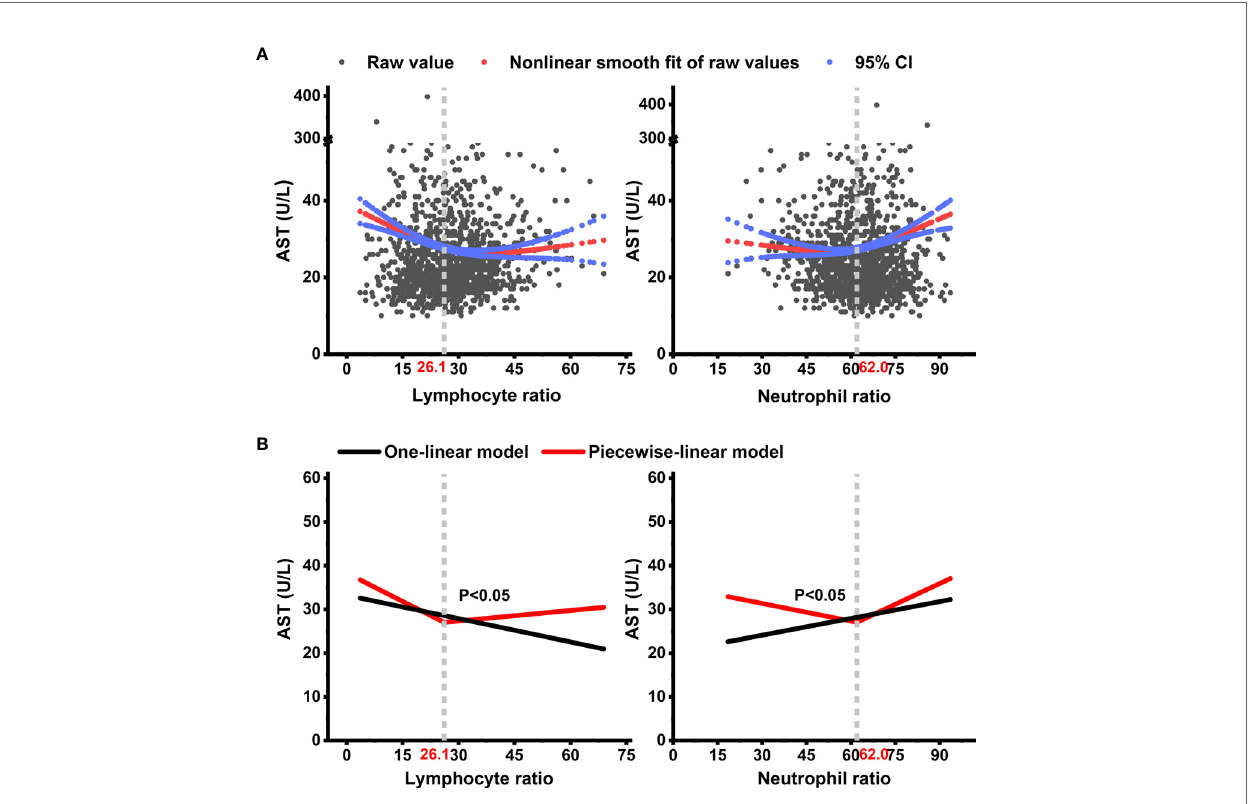
FIGURE 2 | Non-linear trajectories of AST with the changes of lymphocyte ratio and neutrophil ratio during the lateral observation period among COVID-19 patients. Non-linear trajectories of AST with the changes of lymphocyte ratio and neutrophil ratio can be approximated with a piecewise-linear mixed effect model. (A) shows the adjusted smooth fi t of AST data. (B) shows the fi t from the adjusted one-linear and adjusted piecewise-linear mixed-effect models. Models adjusted for fi xed covariates including age, sex, body mass index (BMI), SBP, smoking, alcohol, highest temperature, chest congestion, liver cirrhosis, HBV, and clinical classi fi cation on admission, and time-varied covariates including white blood cell count (WBC), rapid C-reactive protein (RCP), serum amyloid A protein (SAA), alkaline phosphatase (ALP), activated partial thromboplastin time (APTT), glomerular fi ltration rate (GFR), lipoprotein A (LppA), hemoglobin (Hb), sodium concentration, actual base excess (ABE), and anion gap (AG) during the lateral observation period. AST, aspartate transaminase; CI, con fi dence interval.